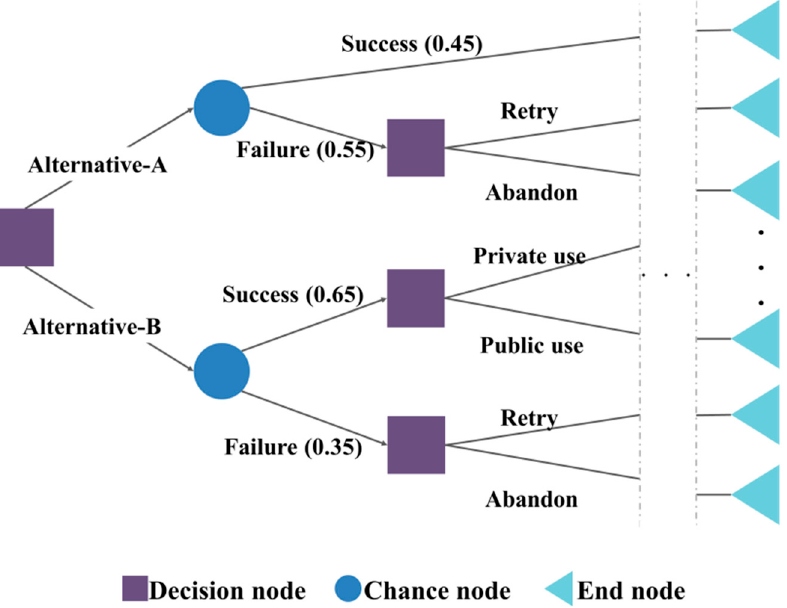
Figure 2. Structure of decision tree (DT).